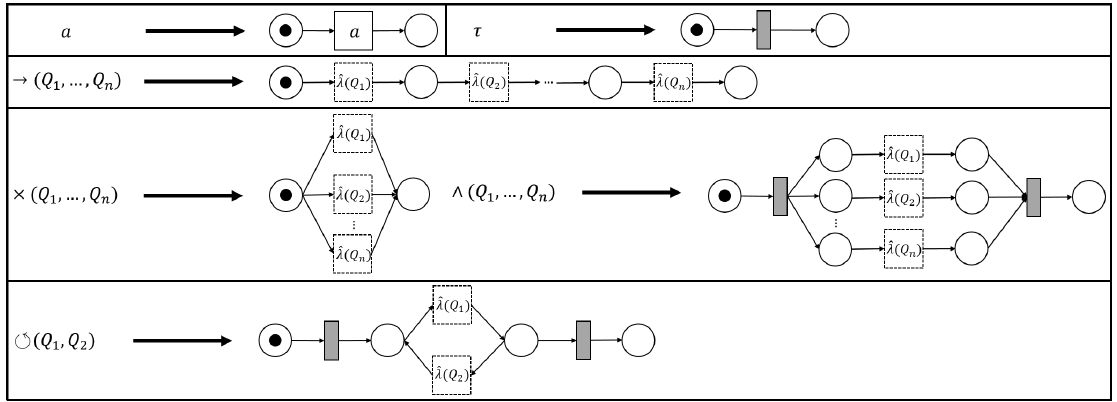
) fragment, connects to p • / • p o i i